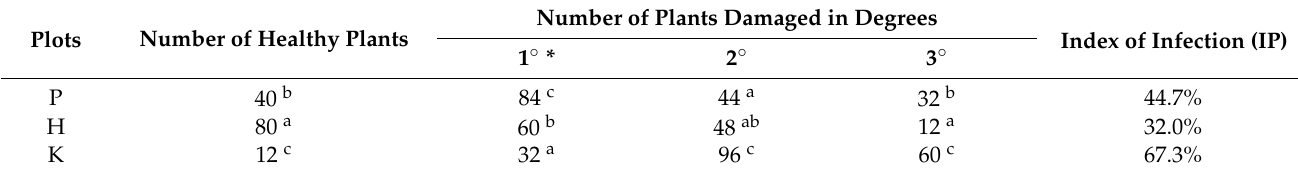
Table 3. The damage of wheat leaves caused by feeding larvae of the cereal leaf beetle. Number of Plants Damaged in Plots Number of Healthy Plants